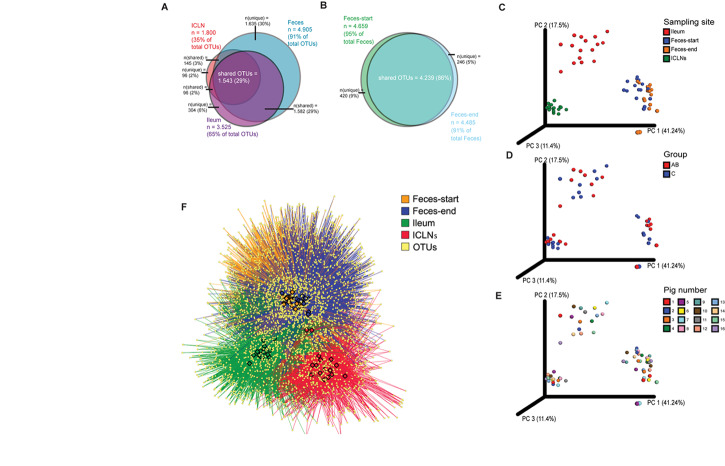
Beta diversity analysis of microbial communities. Overlaps of OTUs detected in (A) the three sample groups (Feces, ileum, ICLNs), and in (B) Feces-start and feces-end. Weighted UniFrac distances based on 16S rRNA gene libraries. Each point represents values from individual libraries with colors expressing (C) Ileum, Feces-start, Feces-end, and ileocaecal lymph node (ICLN) samples; (D) Control and antibiotic group samples (Feces-start samples were not separated into antibiotic-treated (AB) and control groups and are therefore not shown here); and (E) Pig samples. (F) OTU network of bacterial communities. Individual OTUs are represented by light yellow dots. Colored edges connect OTUs with the respective tissue in which they were detected: Ileum (red), Feces-start (blue), Feces-end (orange), ICLN (green). Colored nodes embody individual samples (same color code as edges). OTUs in the center of the network are shared among tissues, whereas OTUs on the outer rim are specifically present in certain tissues.